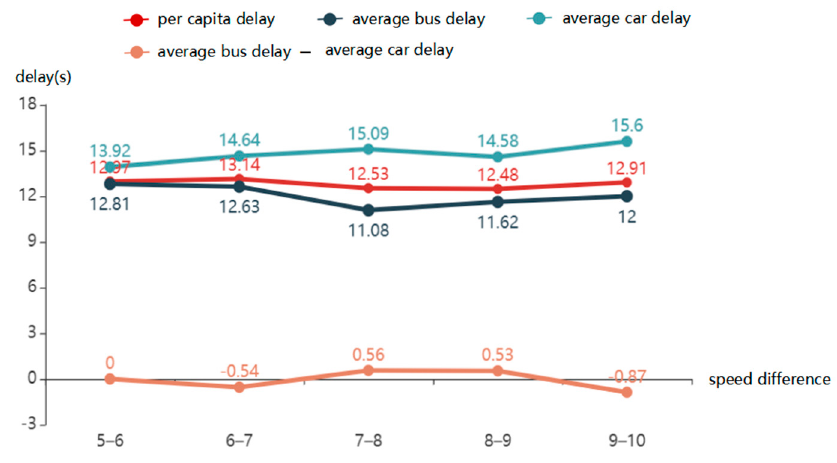
Figure 19. Optimization results for two vehicles with different speed differences.